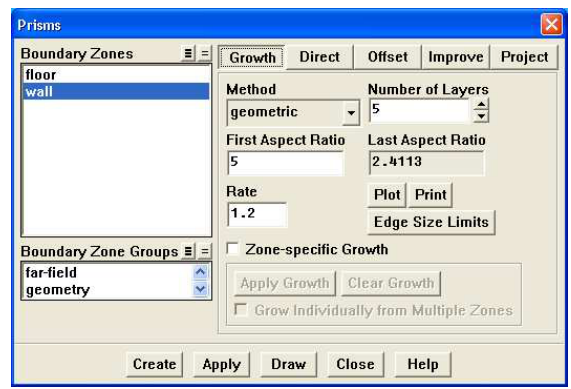
Figure 7 Prism Layer Growth -